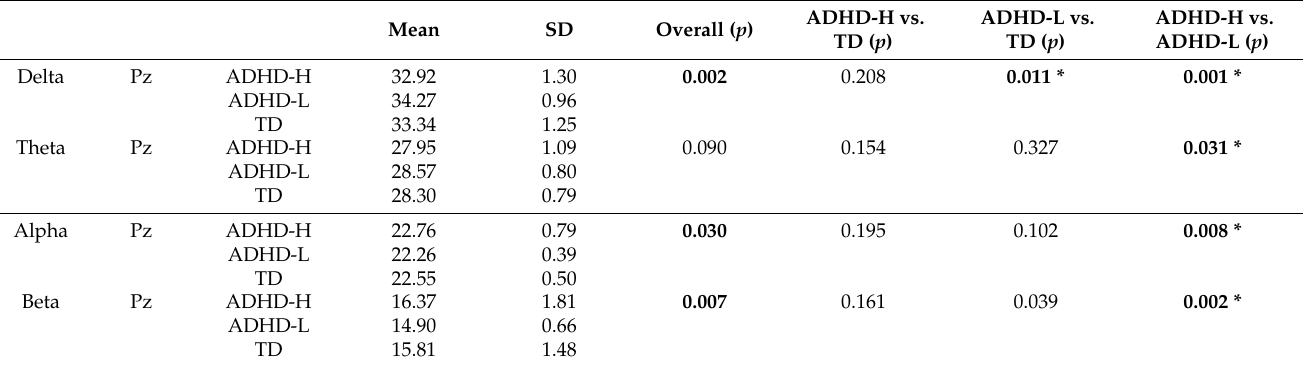
Table 3. Between-group differences in the PSD under significant frequency under fast-rate task